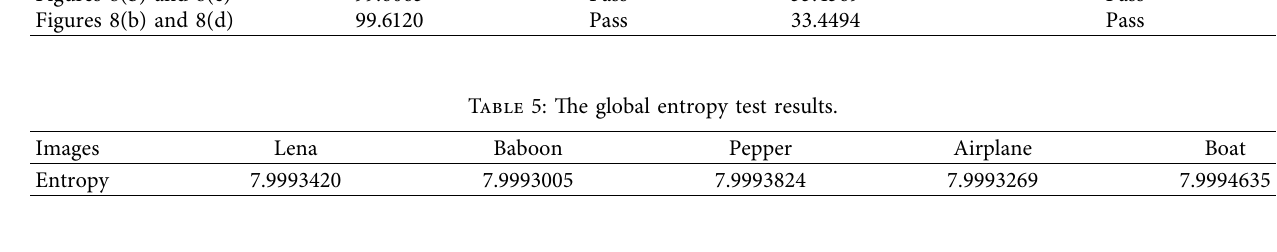
Table 6: The local Shannon entropy test